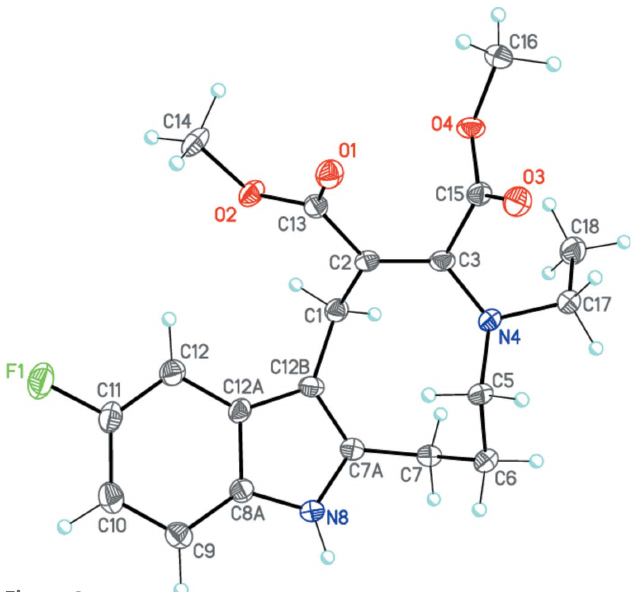
Figure 2 The molecular structure of I . Displacement ellipsoids are drawn at the 50% probability level. H atoms are shown as small spheres of arbitrary